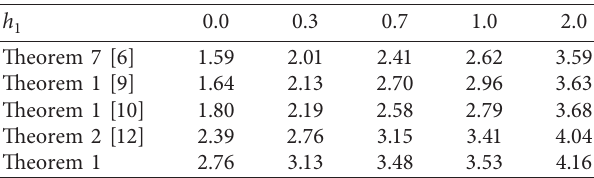
for different h 2